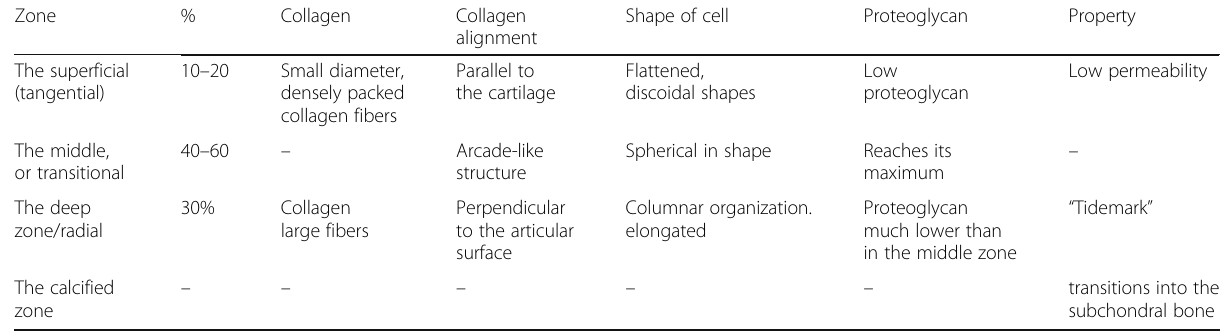
Table 2 Zonal structure of hyaline articular cartilage: from the articulating surface down to the subchondral bone [6, 7] Zone % The superficial (tangential) The middle, or transitional The deep zone/radial The calcified